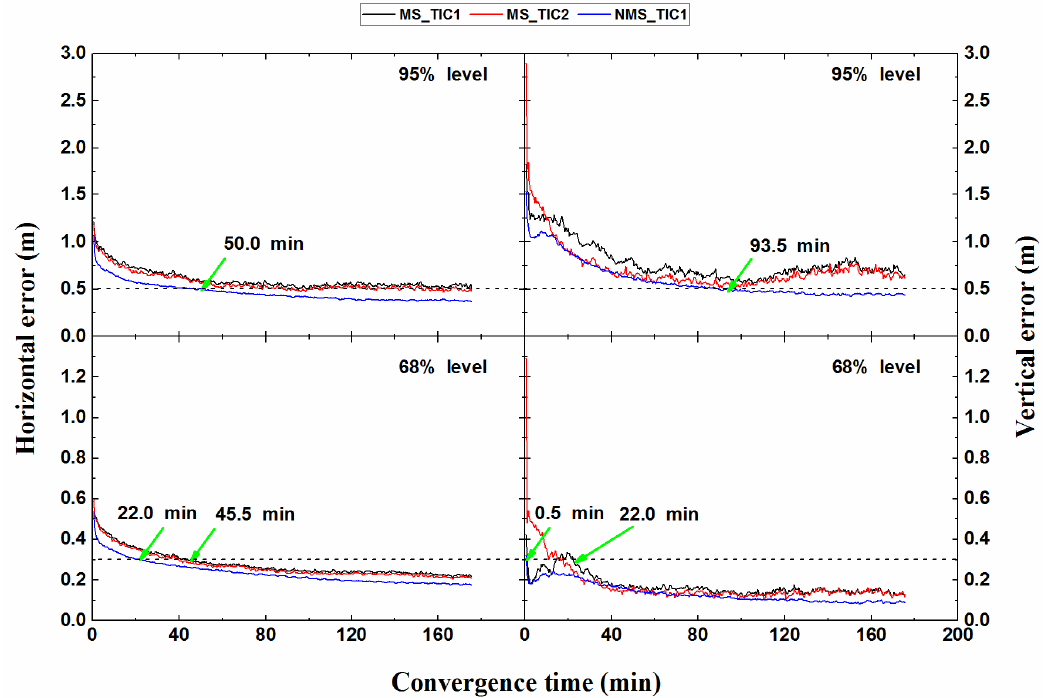
Figure 10. The GPS kinematic SF PPP convergence performance in different constraint schemes during the MS and NMS periods.